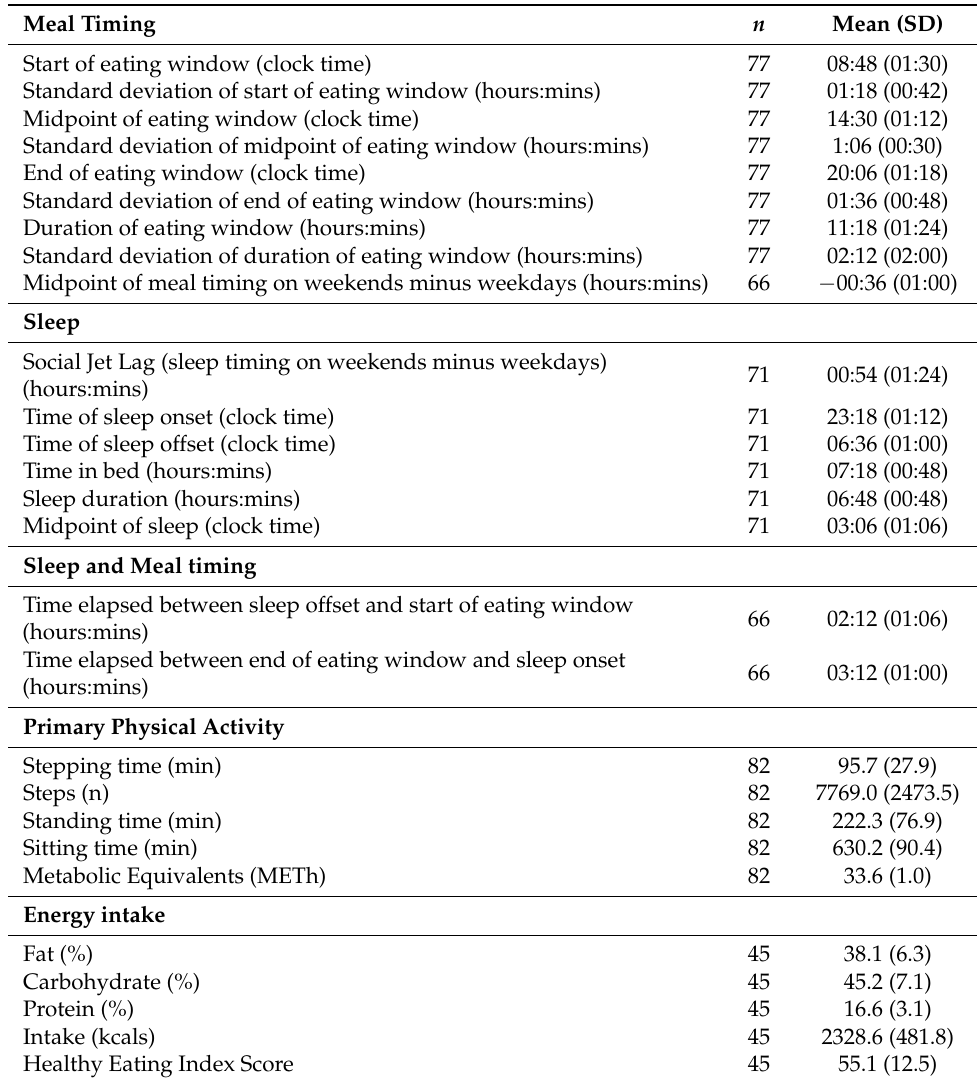
Table 2. Meal timing, sleep timing, physical activity and energy